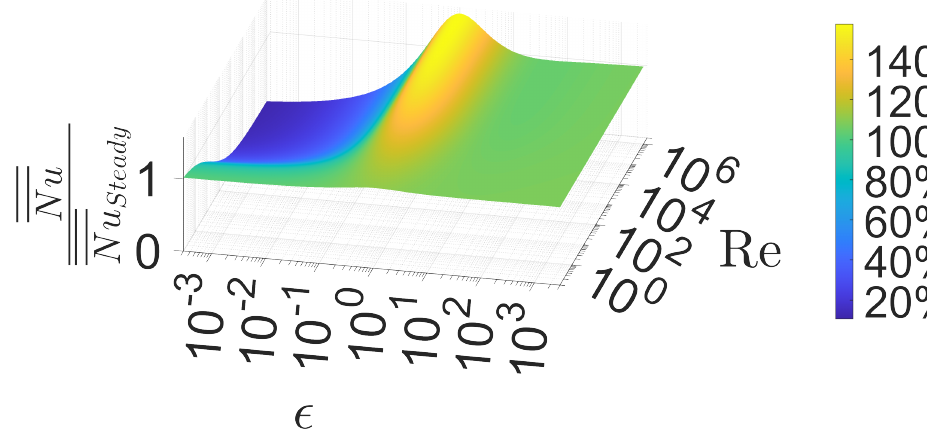
Figure 6. Comparison of Meta-Correlation (4) with Steady Correlation